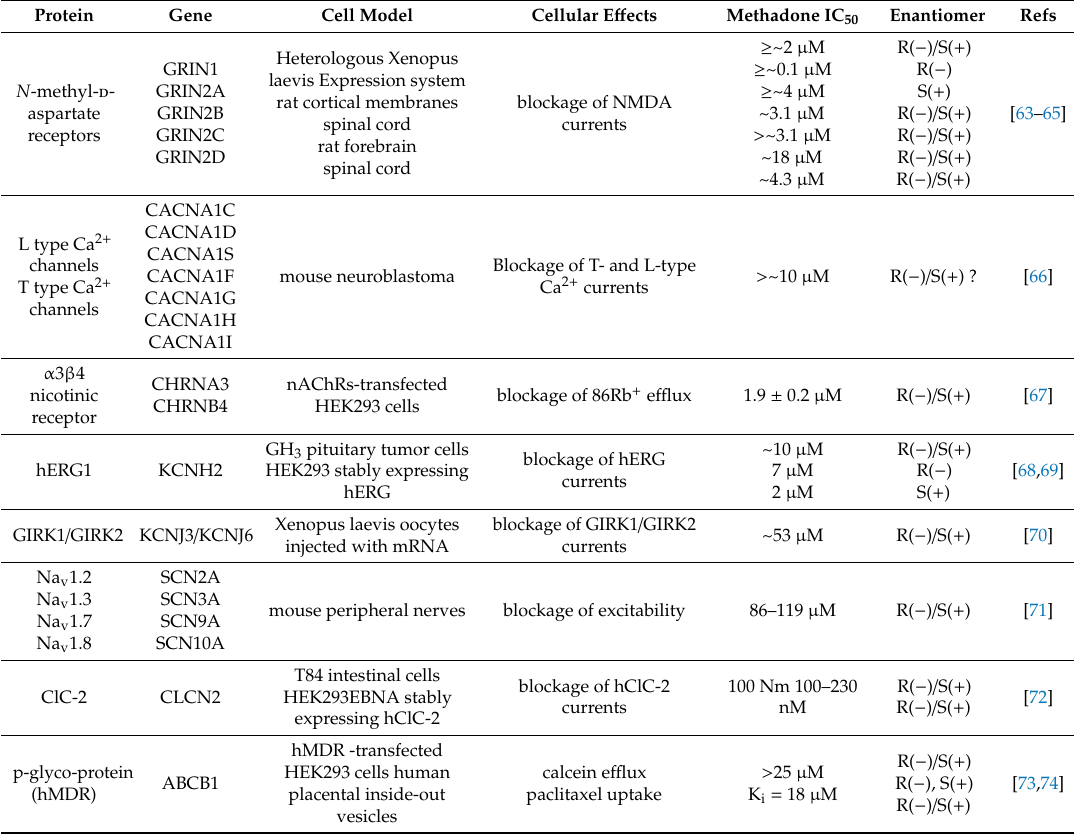
Table 2. Methadone sensitivity of proposed methadone target